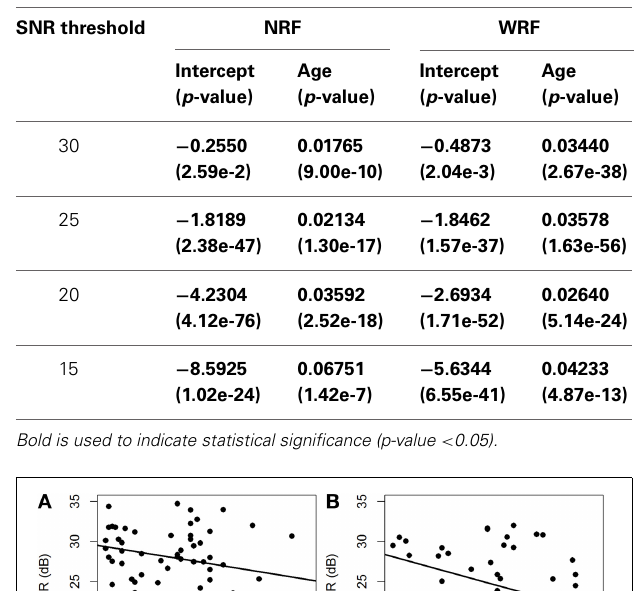
Table 3 | Modeling coefficients and associated p -values computed for logistic modeling of data shown in Figure 5.